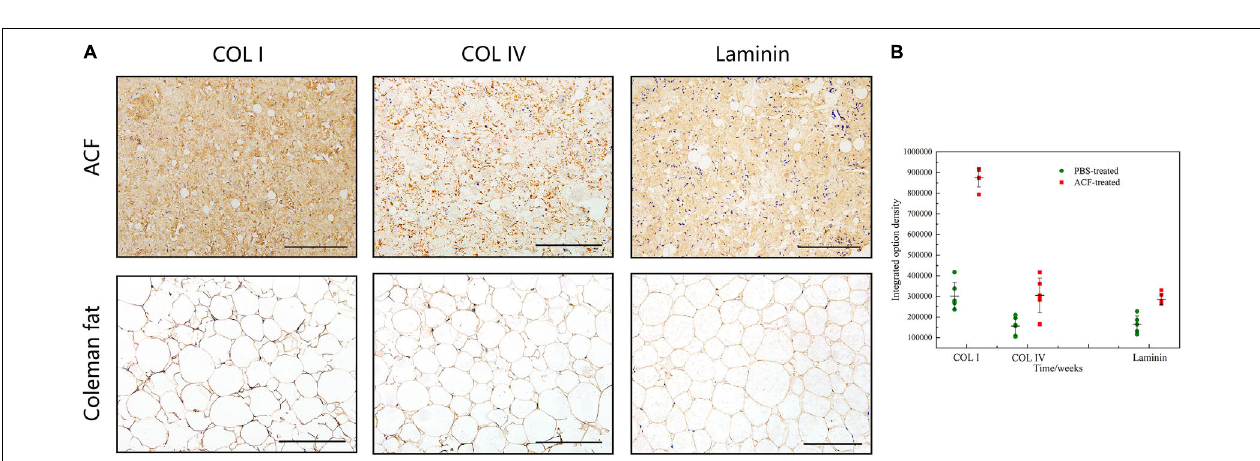
FIGURE 3 | Histological evaluation of Coleman fat and ACF. (A) Masson staining of Coleman fat and ACF. Collagen was expressed in the entire field of view in ACF, while the collagen components in Coleman fat can only be detected in the surrounding adipocytes. Scale bar = 200 µ m. (B) Scattered, stripe-like collagen fragments in ACF were observed in the bright-field image. Scale bar = 1 cm.